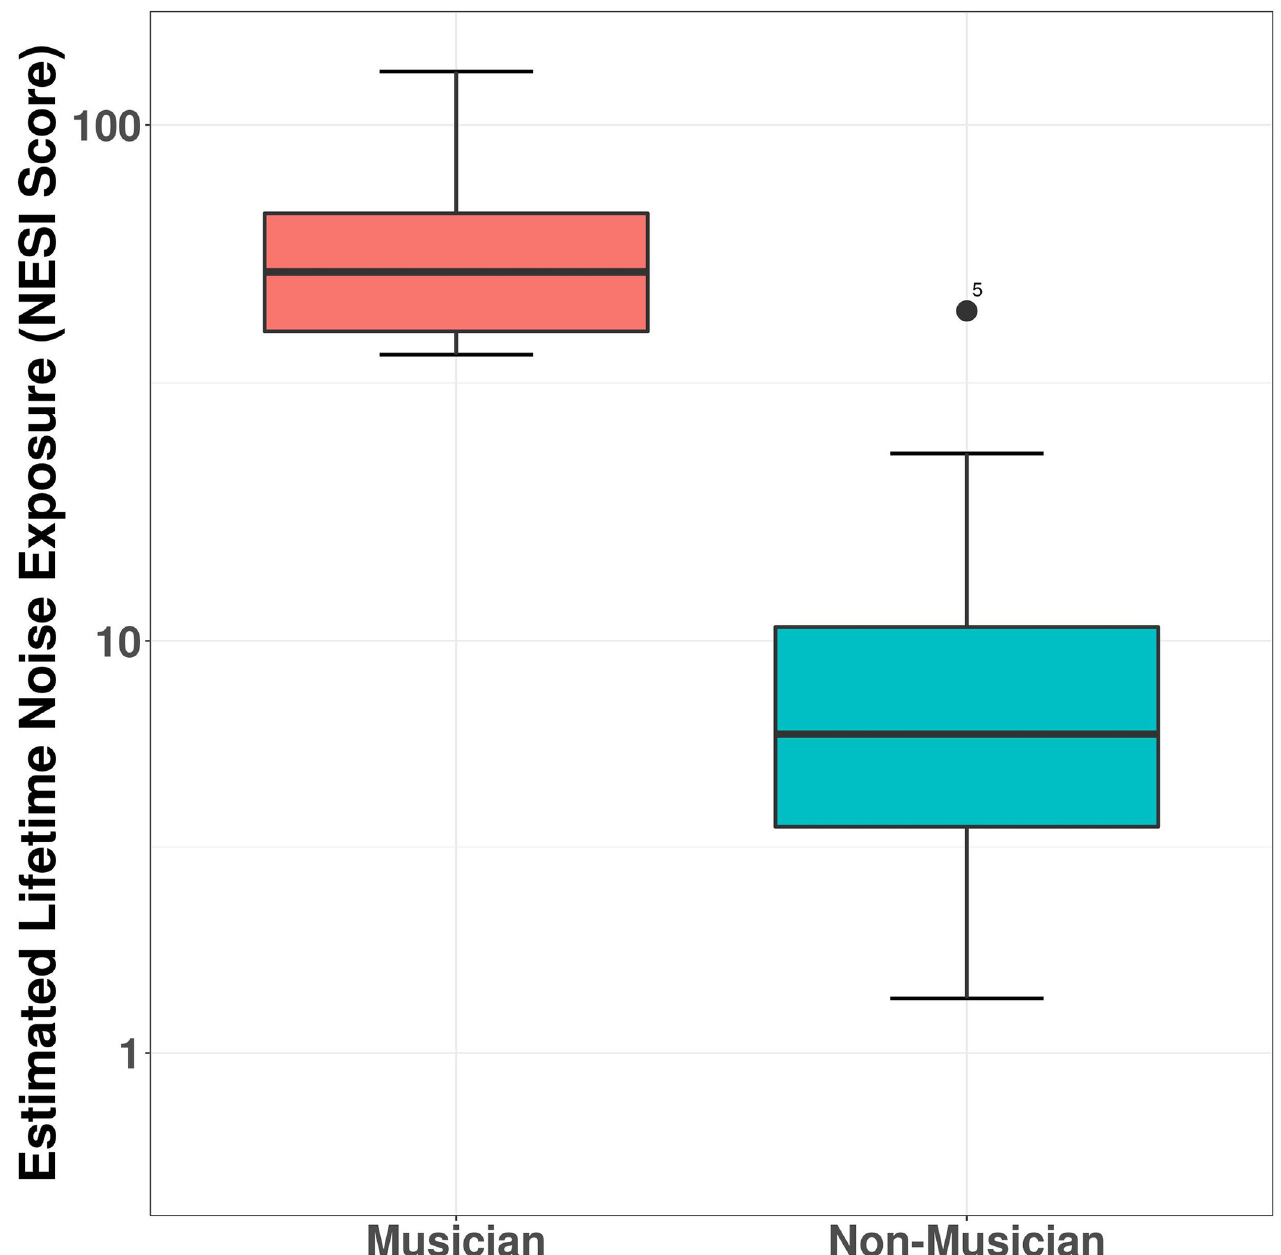
Fig 4. NESI scores for musicians and non-musicians. The boxplots show the smallest observation, 25% quantile, median, 75% quantile and the largest observation. https://doi.org/10.1371/journal.pone.0278845.g004 3, which is high according to Fox [22]. The model with only PTA and NESI was significant [Adjusted R2 = 0.212, F(2,31) = 5.429, p = 0.01] with the NESI being the only significant pre- dictor ( β = 0.503, p = 0.003). The coefficient for PTA did not vary significantly ( β = -0.042, p = 0.791) from that of the first model, so the musicianship did not confound the association with PTA. Instead, the coefficient for NESI increased (from 0.277 to 0.503) and became statis- tically significant suggesting that the effect of NESI on the preferred music-listening level was confounded by musicianship.